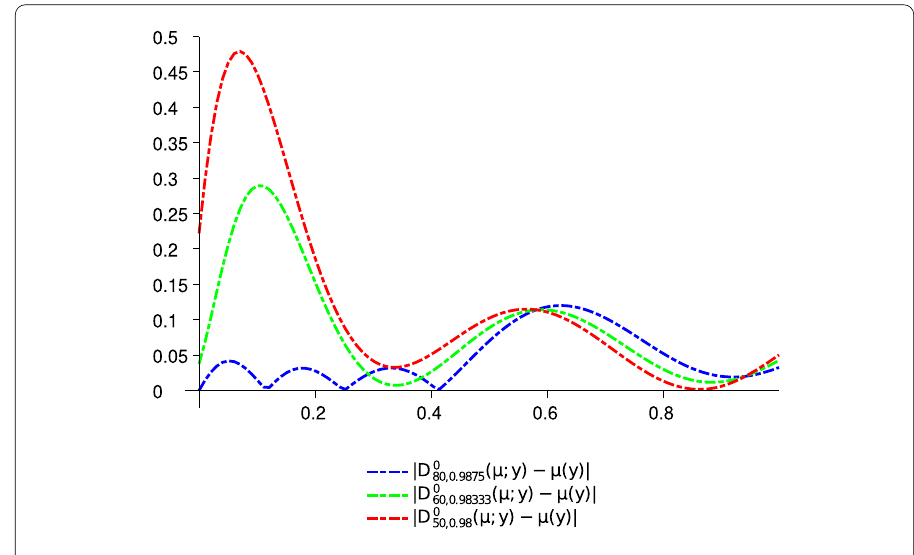
Figure 4 The error of approximation D 0 m , q ( μ ; y ) to μ ( y ) for fixed values of q and m